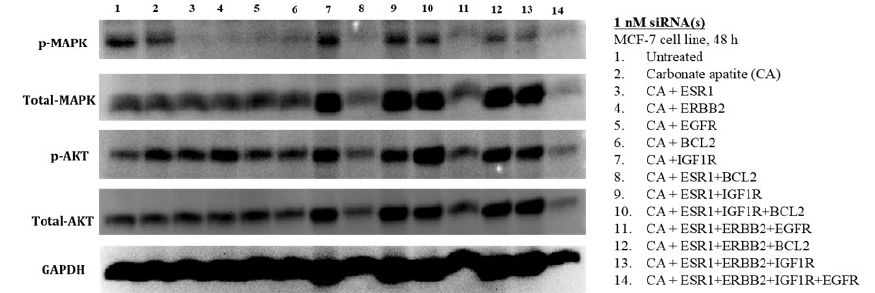
Figure 6. Effects of intracellular delivery of various CA ‐ siRNA complexes on expression and activation of AKT and MAPK proteins in MCF ‐ 7 cell line. Preparation of the CA ‐ siRNA(s) complexes involved introduction of ESR1, ERBB2, IGF1R, EGFR and BCL2 siRNAs individually or in combination with 3.5 mM of CaCl 2 to 1 mL of bicarbonate ‐ buffered DMEM (pH 7.4). The mixture was allowed incubation at 37 °C for 30 min before the addition of 10% FBS. The cells were incubated for a consecutive period of 48 h with the prepared complexes, prior to cell lysis for protein extraction and Western blot analysis. Proteins were loaded on SDS ‐ PAGE and transferred onto nitrocellulose membrane for detection of p ‐ MAPK, p ‐ AKT, total MAPK, total AKT and GAPDH (housekeeping